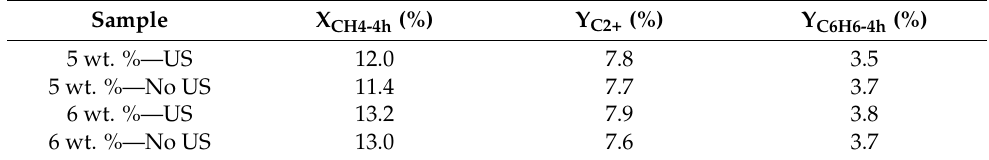
Figure 7. ( a ) Methane conversion, ( b ) overall hydrocarbon yield, and ( c ) benzene yield for Mo/ZSM-5 catalysts prepared by ion-exchange with ultrasound (US) and without ultrasound (No US). Table 3. Catalytic activity of the Mo/ZSM-5 catalysts prepared with and without ultrasound for non-oxidative methane dehydroaromatization after 4 h on